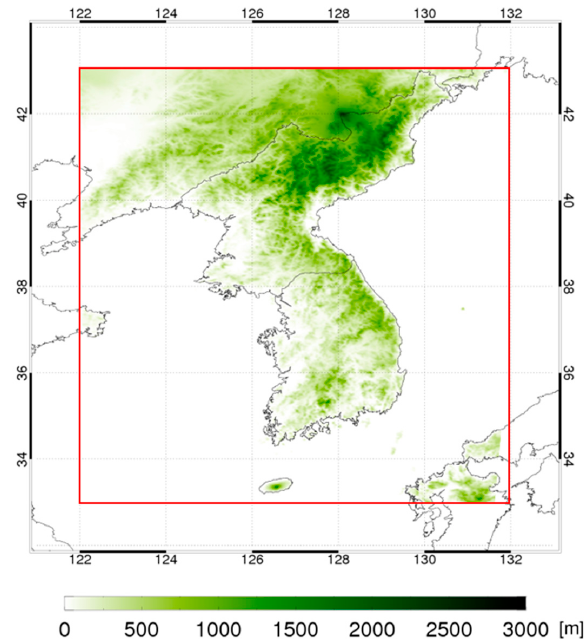
Figure 1. Korean Peninsula region (red box) and altitude distribution for energy budget calculation.